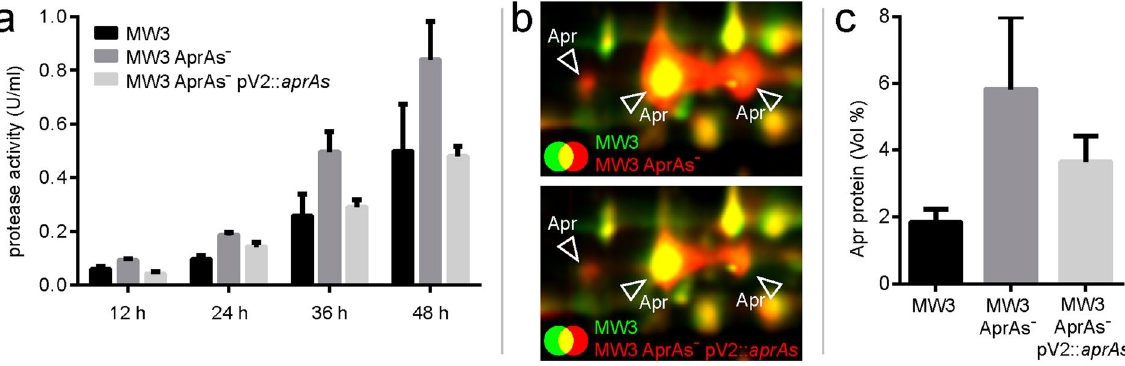
Figure 4. Protease activity and Apr protein expression in B . licheniformis MW3, MW3 AprAs − and MW3 AprAs − pV2:: aprAs . The strains were grown in 400 ml M9 skim milk medium for 48 h. ( a ) The cell culture supernatants of samples from time points 12 h, 24 h, 36 h and 48 h were used for quantitative exoprotease activity determination. The absolute value of protease activity is shown as the average of three independent experiments, each with triplicate measurements. The exoprotease activity increased from 12 h to 48 h and is clearly stronger in B . licheniformis MW3 AprAs − in all experiments compared to B . licheniformis MW3 and MW3 AprAs − pV2:: aprAs . The error bars display the standard deviation and the colour legend is shown in the figure. ( b ) Extracellular proteins were isolated from supernatants of 400 ml M9 skim milk cultures after 48 h of growth. The protein fractions were separated by 2D-gelelectrophoresis. A gel image of B . licheniformis MW3 (green) was overlaid with the respective image of MW3 AprAs − . The volume of the three identified Apr protein spots is strongly increased in B . licheniformis MW3 AprAs − (red) compared to the original strain B . licheniformis MW3 (green). In addition, the gel image of B . licheniformis MW3 (green) was overlaid with the respective image of MW3 AprAs − pV2:: aprAs (red). After vector complementation, the effect of the mutation is reversed. B . licheniformis MW3 AprAs − pV2:: aprAs shows only a slight increase in Apr protein expression compared to B . licheniformis MW3. ( c ) To quantify the Apr expression the spot volumes (in percentage of the whole protein spot volume) were calculated. The average of the normalized spot volumes of three replicates is shown and the standard deviation is given. The Apr protein expression in the extracellular proteome of B . licheniformis MW3 AprAs − is approximately three times increased compared to the original strain B . licheniformis MW3. The Apr expression of B . licheniformis MW3 AprAs − pV2:: aprAs is reduced compared to the precursor strain B . licheniformis MW3 AprAs − , but still higher than in B . licheniformis